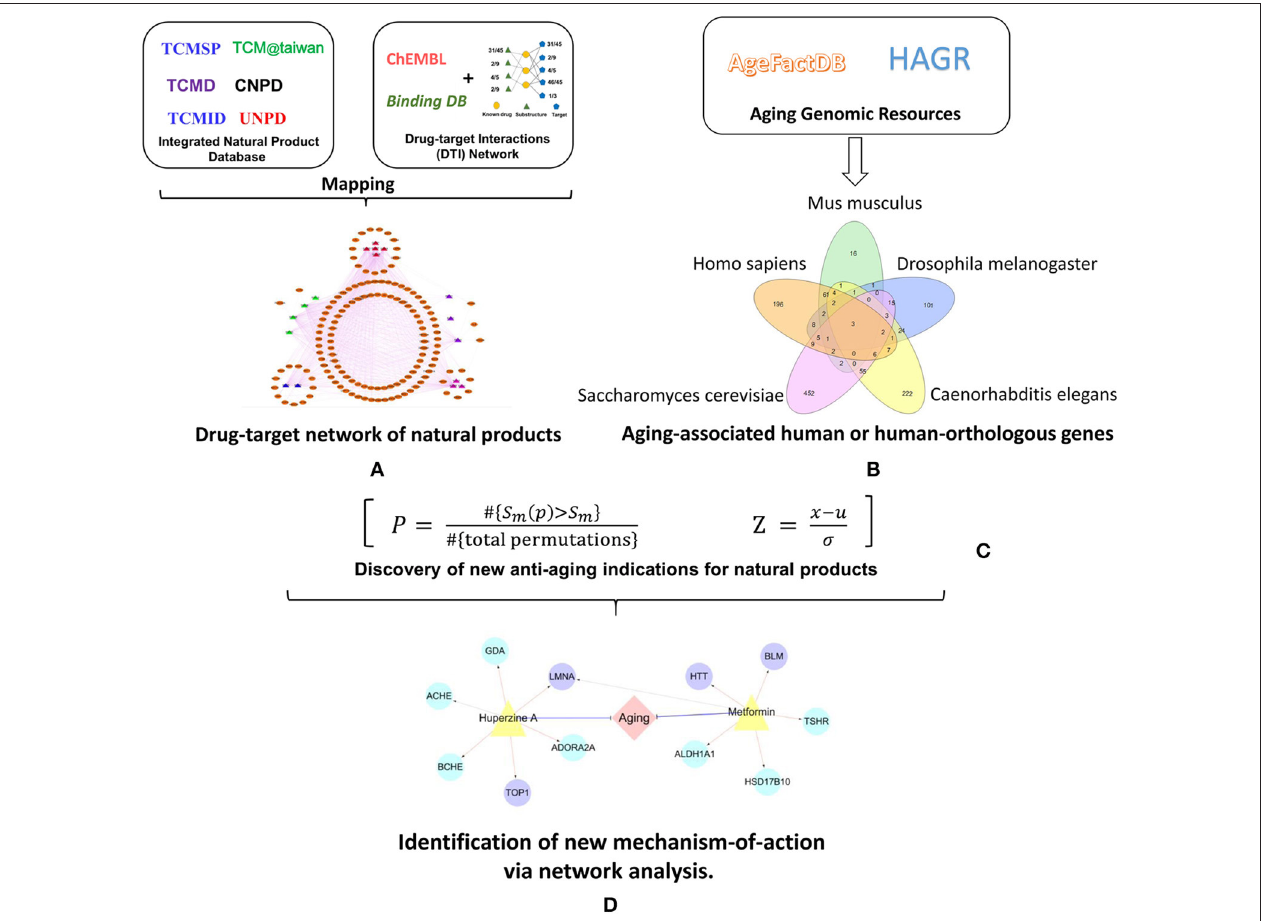
FIGURE 1 | Schematic diagram of the systems pharmacology infrastructure for identification of aging-associated indications by natural products. (A) Construction of drug-target network of natural products. (B) Manual curation of aging-associated genes. (C) Discovery of new anti-aging indications for natural products via network-based prediction. (D) Identification of new anti-aging mechanism-of-action via network